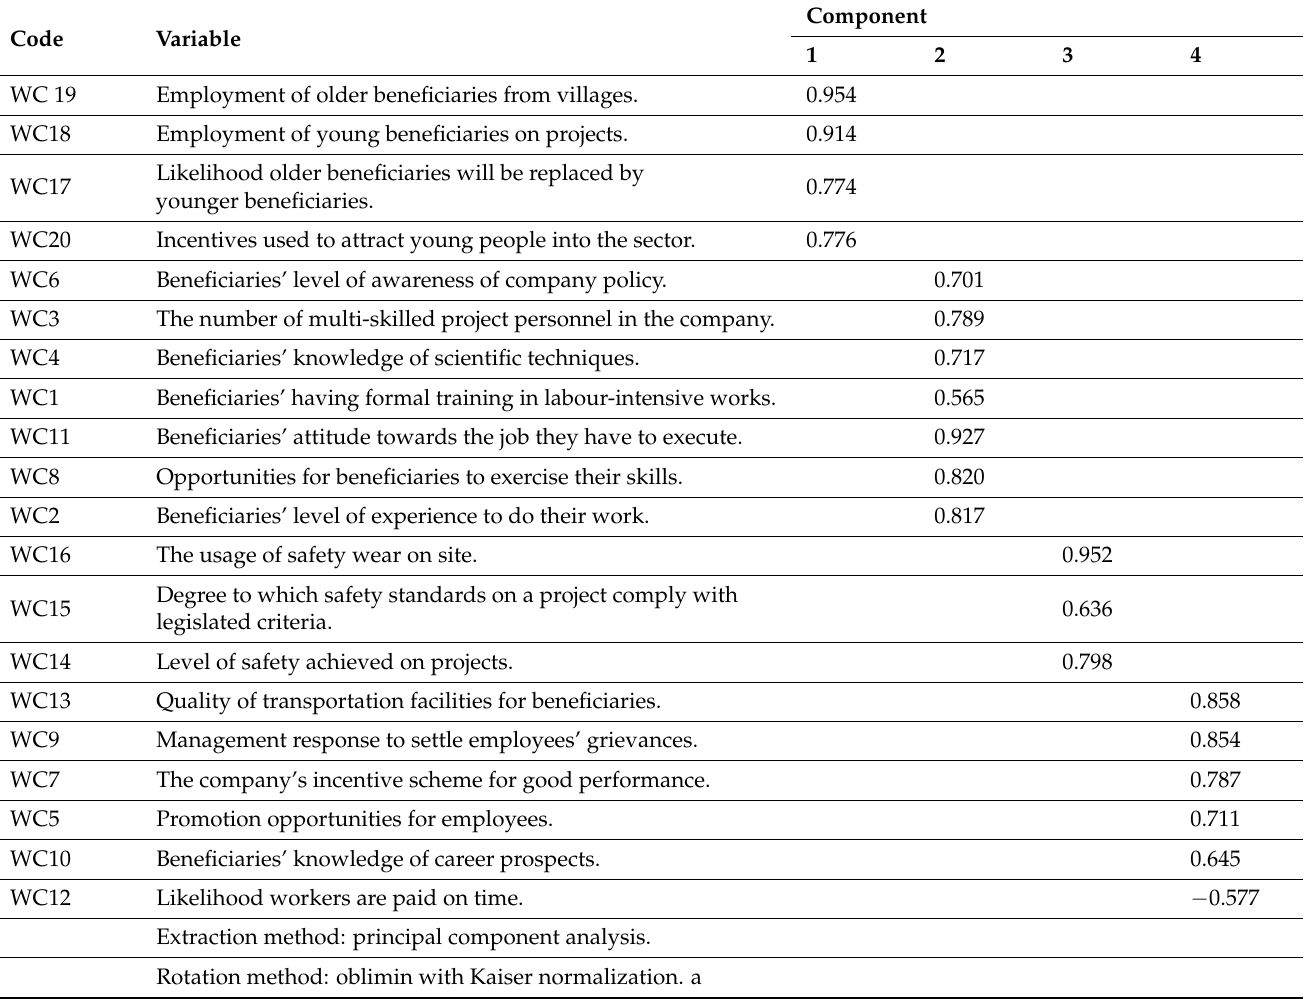
Table 8. Rotated factor matrix a for worker component.